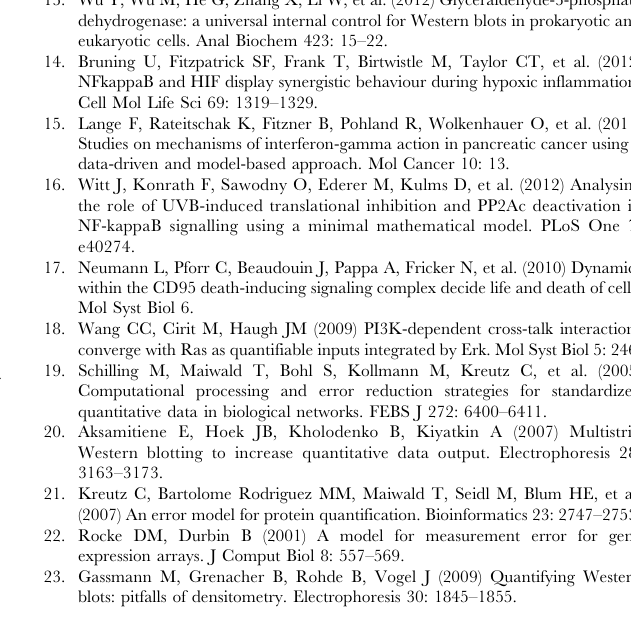
Figure S5 Effect of the normalisation on the coefficient of variation of the normalised data. (A) CVs are shown for the distribution of the simulated data before normalisation, after normalisation by first condition, after normalisation by sum of all data points in a replicate and after normalisation by least squared differences. The mean coefficient of variation is computed as the average across the eight conditions. Mean and standard deviation of the data before normalisation is given in Figure 3A of the main text, and here is normally distributed. (B) Before normalisation, the response to Condition 2 has a coefficient of variation of 0.2, as shown in Figure 3A of the main text. Condition 2 is then normalised by fixed point, with Condition 1 as normalisation point. Here we show how the coefficient of variation of normalised Condition 2 changes for increasing coefficient of variation of the normalisation point Condition 1. Figure S6 Effects of normalisation on false positives and false negatives when applying t-test for equality of the mean. (A) We consider responses to eight conditions with normal distributions with CV of 0.2 and means of the conditions from 1 to 8 equal to: 1, 2, 2, 4, 7, 7, 18, 18. A number n = 5 of sampled replicates are obtained from these distributions and normalised using the normalisations above. Using these replicates before and after normalisation, conditions are tested using a two- tailed t-test with threshold p-value of 0.05. We repeat this procedure a large number of times and estimate the percentage of false positives. (B) In analogy with (A), we estimate the number of false negatives considering means of the conditions from 1 to 8 equal to: 1, 2, 3, 4, 7, 10.5, 18, 27. Notice that for a fair comparison, when testing two conditions, one has a mean that is always 2/3 the mean of the other, e.g. Condition 5 has mean 7 and Condition 6 has mean 10.5, with 7/10.5 =2/3. Figure S7 Figure S3 of [ 25 ] . Experimental data used in Figures 3C and 4. The experiments shown in Figure S5 were performed as described by Rauch et al. in [25].